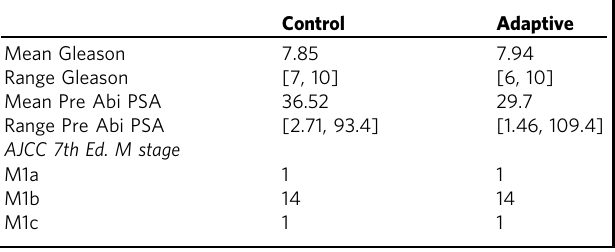
Table 1 Gleason scores and metastatic locations in the adaptive therapy and standard therapy cohorts.